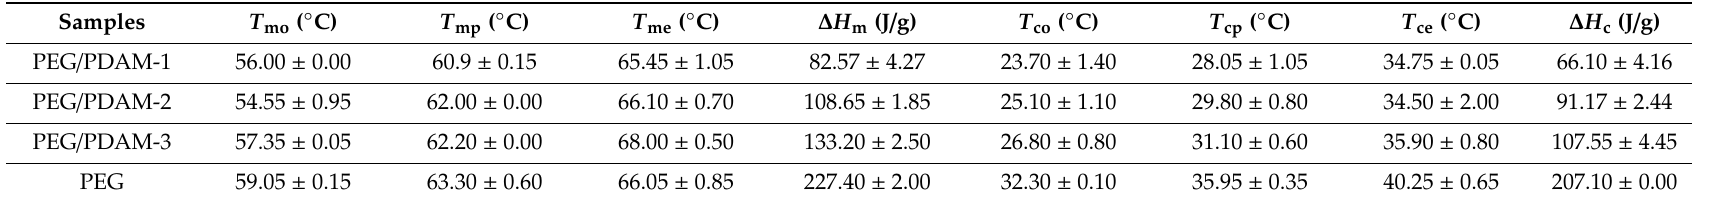
Table 1. Phase change temperatures and latent heat values of the PEG and PEG / PDAM composites a